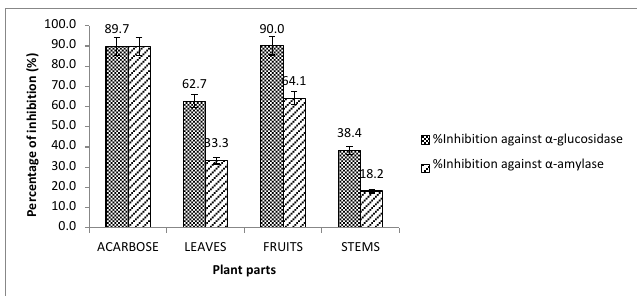
Figure 1: Inhibition percentage of different plant parts of P. niruri against Figure 1 demonstrated the percentage of α -glucosidase and α -amylase inhibitory activity of these enzymes with the presence of potential inhibitor of different plant parts of P. niruri and acarbose. It can be seen that fruit showed the highest inhibitory activity (90.0%) against α